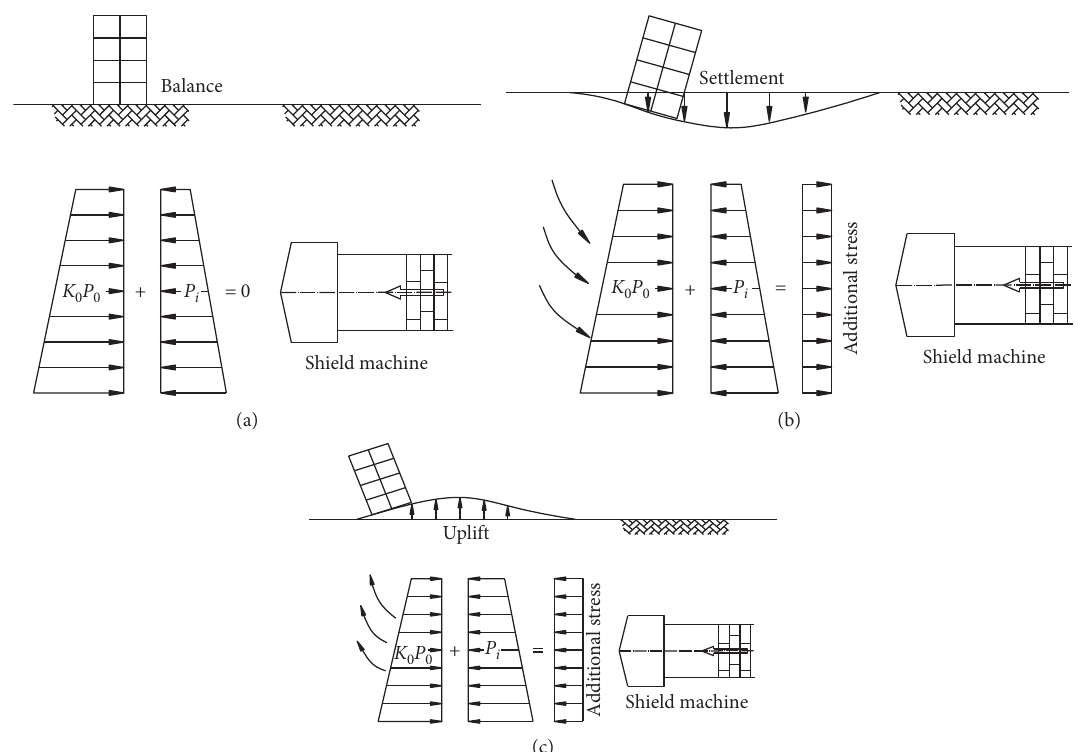
Figure 1: Surface movement behavior during the shield machine advancing. (a) P